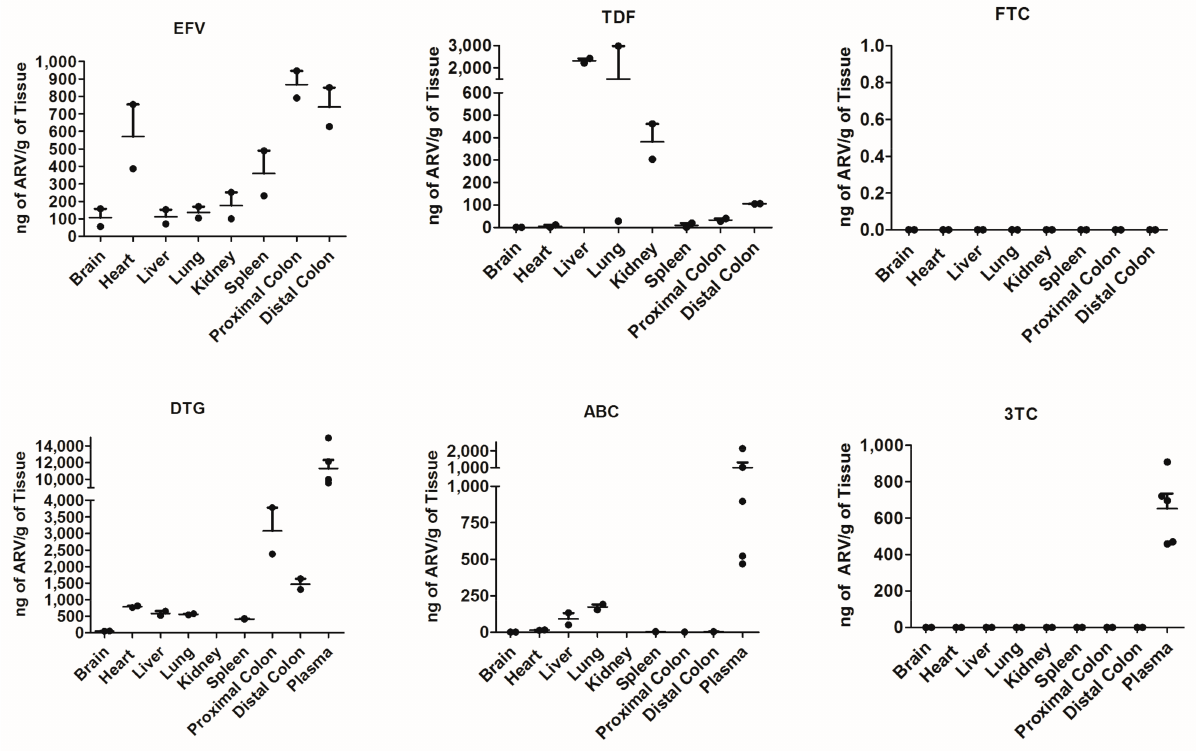
Figure 2. ARV chow delivers drugs into the peripheral tissue. The concentration of the individual ARVs measured by mass spectrophotometry in the brain, liver, plasma, spleen, kidneys, proximal and distal colon, lungs and heart of C57/BL6 mice that were fed ARV pellets every day for 4 weeks. Presented as ng of ARV/g of tissue. N = 2 mice. EFV: Efavirenz, DTG: Dolutegravir, TDF: Teno- fovir disoproxil fumarate, ABC: Abacavir, 3TC: Lamivudine, FTC: Emtricitabine. Error bars show mean ±